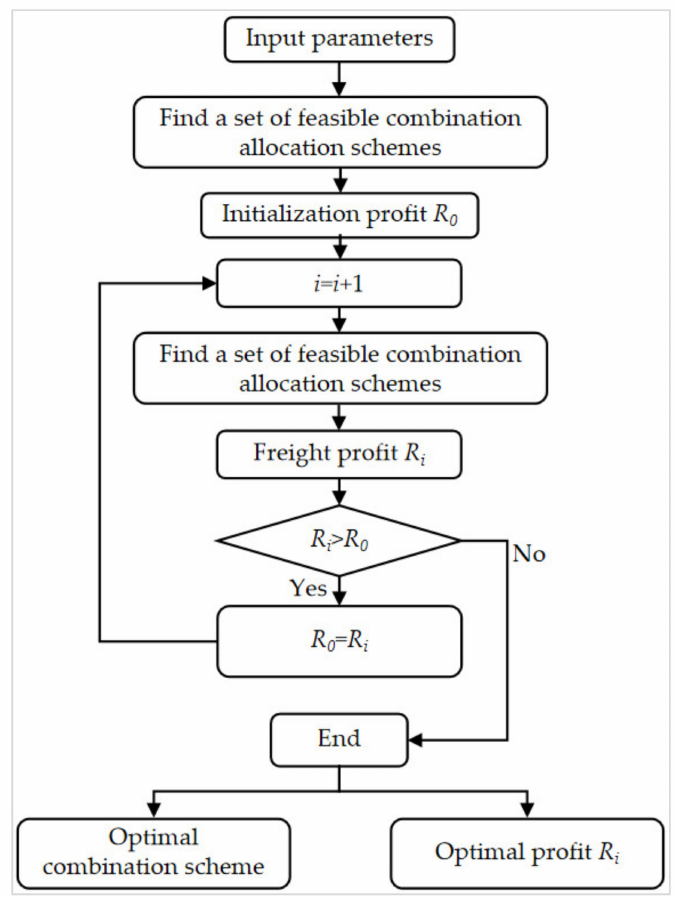
Figure 1. The process of model